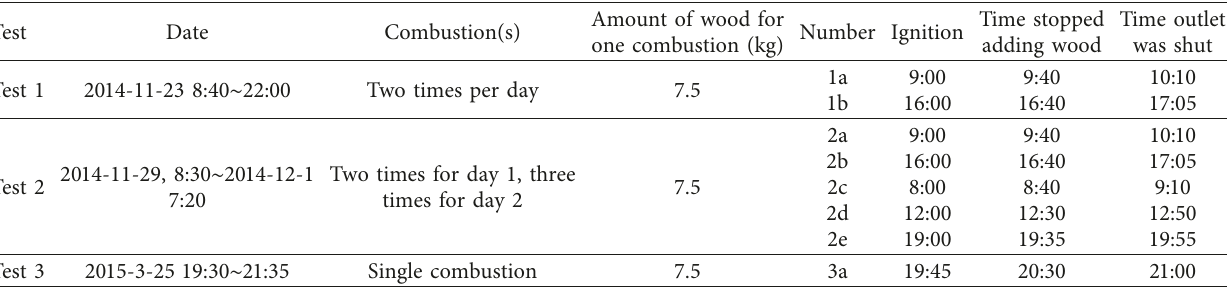
Table 3: Testing instruments used in the experiment. Parameter Instrument